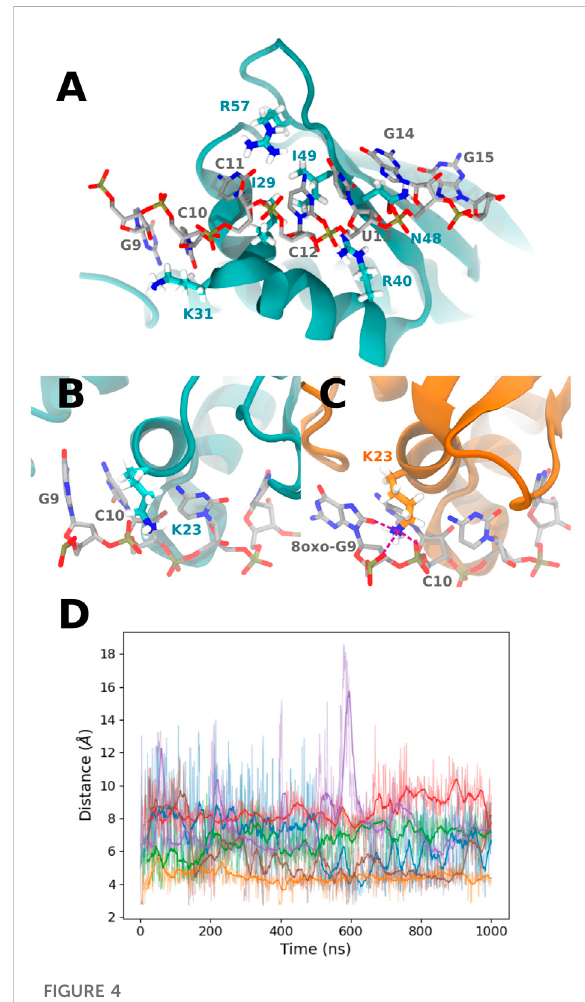
FIGURE 4 (A) Representation of the PCBP1 residues interacting with all RNA sequences, mostly with nucleobases at positions 10 to 14 (from the control sequence in this picture). (B) Example of K23 conformation in the presence of the control sequence. (C) K23 interaction with 8-oxoG9 O8 and 8-oxoG9 and C10 phosphate in the presence of the ° GCCCUG ° G sequence. Interactions are represented with purple dashed lines. (D) Time evolution of the distance between 8-oxoG9 O8 and the K23 N ζ atom for the six studied RNA sequences: control